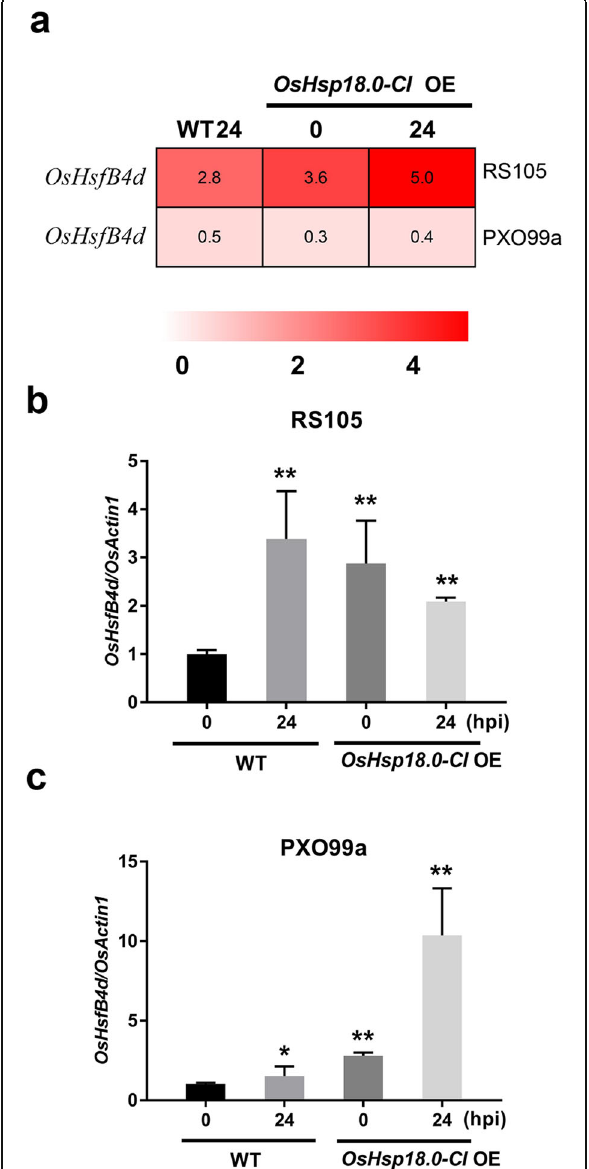
Fig. 1 OsHsfB4d expression is induced by Xanthomonas oryzae pv. oryzicola (Xoc) and Xanthomonas oryzae pv . oryzae (Xoo) inoculation. a Hierarchical cluster analysis of OsHsfB4d using the OsHsp18.0-CI RNA-seq data. Quantification of the expression level of OsHsfB4d in response to RS105 (b) or PXO99a (c) by qRT-PCR. Fully expanded leaves of six-week-old ZH11 and OsHsp18.0-CI -OE plants were harvested at 0 and 24 h post inoculation. The bars represent the mean (three replicates for gene expression) ± SD. The significance of expression compared to that at 0 h in the WT at P values of less than 0.05 and 0.01 are indicated by “ * ” and “ ** ” ,